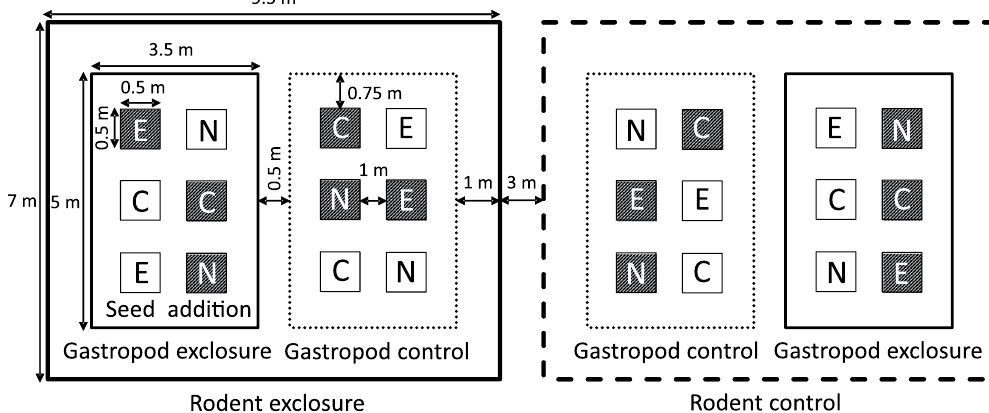
Figure 6. The graph exemplifies the experimental design showing one out of five blocks. Each block includes one rodent exclusion plot (indicated by a bold solid line) and rodent control plot (indicated by a bold dashed line) plot. Within each plot, one gastropod exclusion subplot (indicated by a solid line) and gastropod control subplot (indicated by a dashed line) were established. Within each subplot, sub-subplots (depicted with smaller squares) were established that were either subjected to disturbance (shaded squares) or were left undisturbed (open squares). These sub-subplots were furthermore randomly assigned to receive no seeds (C), a seed mixture of 20 exotic species (E) or 20 native species